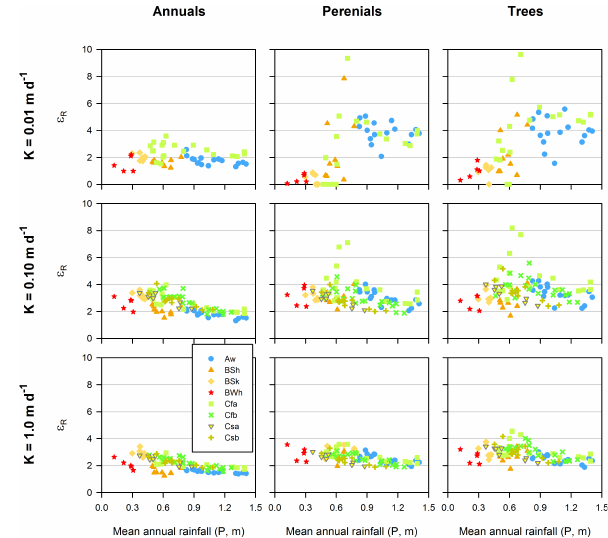
Fig. 7. Scatter plots of mean annual rainfall ( P ) and percent P which becomes mean annual recharge ( R/P ) for all modelled lo- cations within considered climate types, under soil with selected hydraulic conductivities and vegetation types.